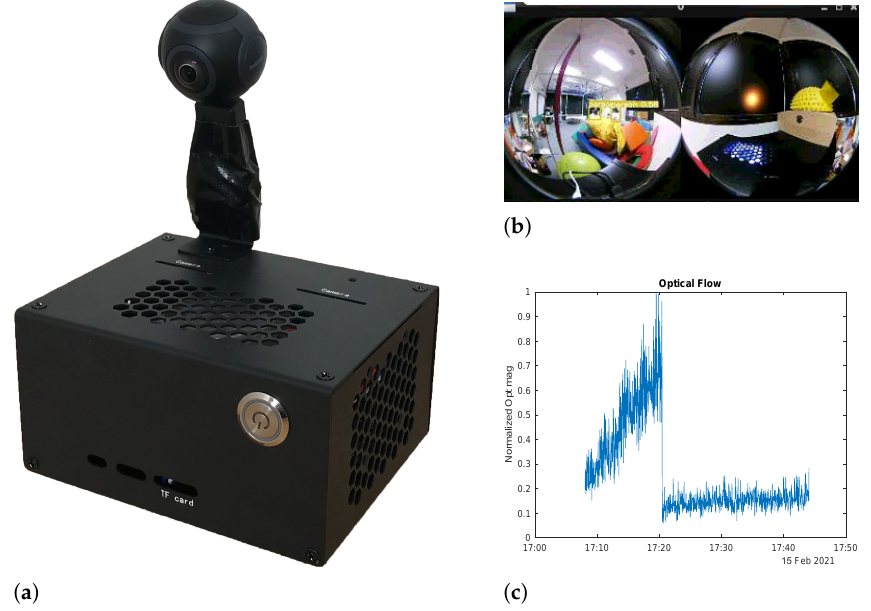
Figure 4. ( a ) Picture of the video device. ( b ) Screenshot of a people detection frame during a test session. ( c ) Example fragment of the optical flow signal recorded during a test